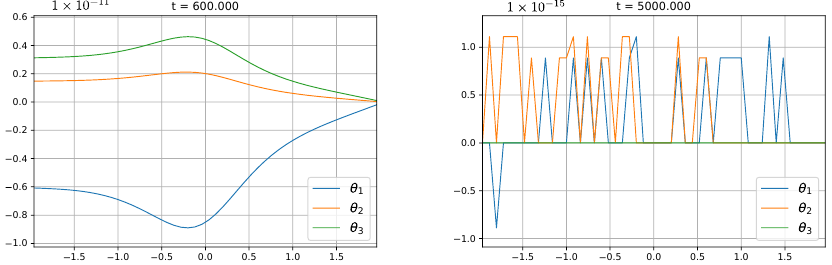
Figure 12. Difference on the relative density between the perturbed and unperturbed steady